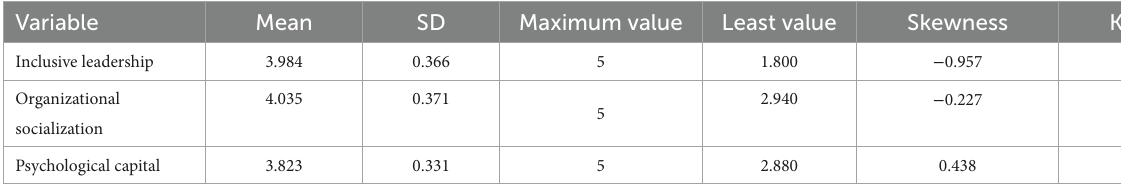
TABLE 3 Descriptive statistics of scales.